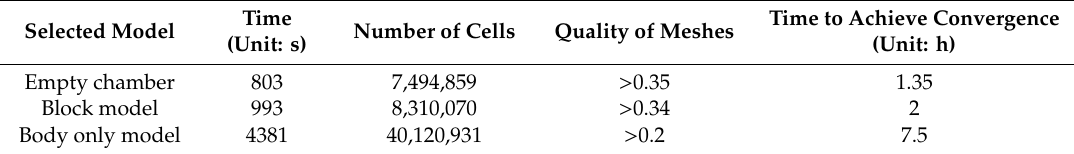
Table 3. The e ffi ciency comparison of di ff erent Table 3. The efficiency comparison of different models.